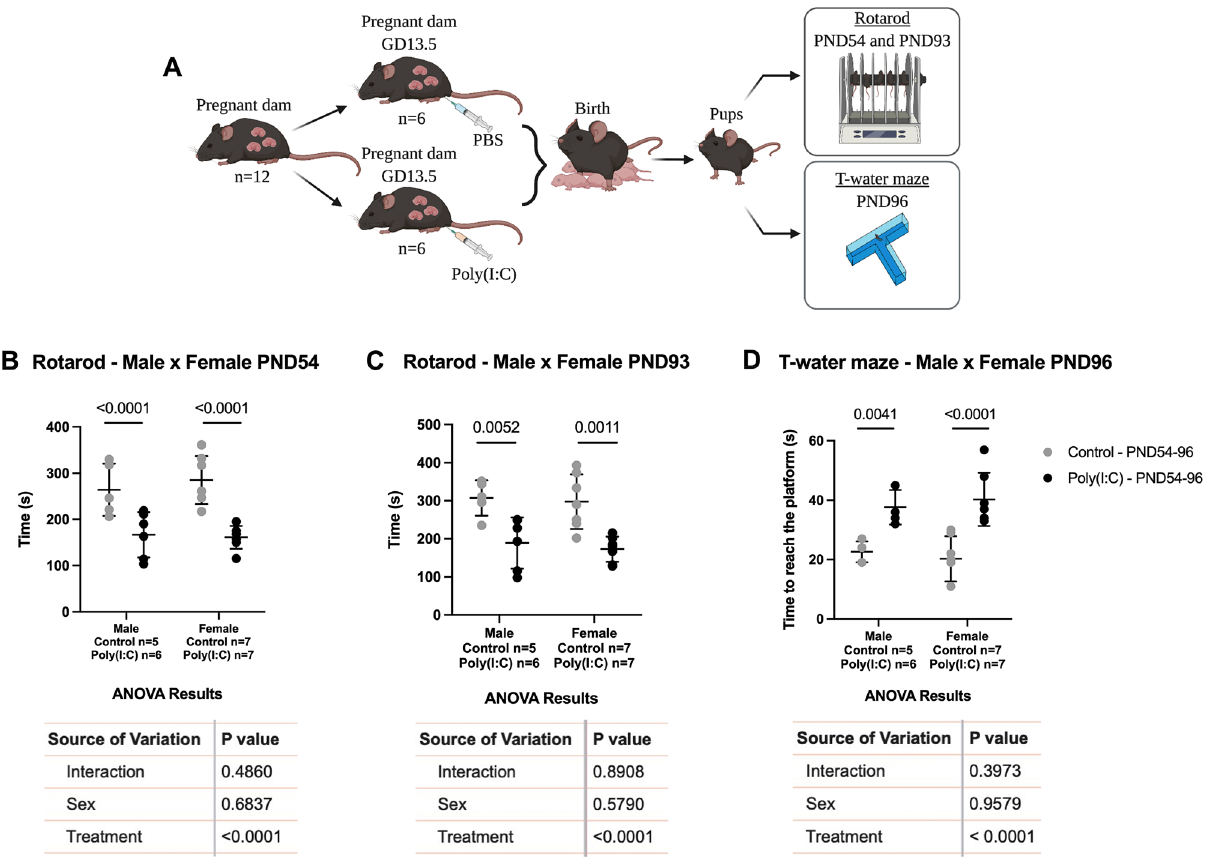
Figure 6. Maternal mid-pregnancy exposure to poly(I:C) induces motor coordination and cognitive deficits in both male and female offspring. ( A ) Experimental scheme (created with BioRender.com). ( B,C ) Rotarod test performed in male and female offspring at PND54 ( B ) and 93 ( C ). ( D ) T-water maze task performed at PND96. Each point represents a litter. The graphs were plotted in aligned dot plot, gray circles represent the male’s and female’s control groups, and black circles represent the male’s and female’s poly(I:C) groups. The values are plotted as individual values and they are expressed as mean ± SD. Two-way ANOVA with Šídák’s multiple comparisons test was